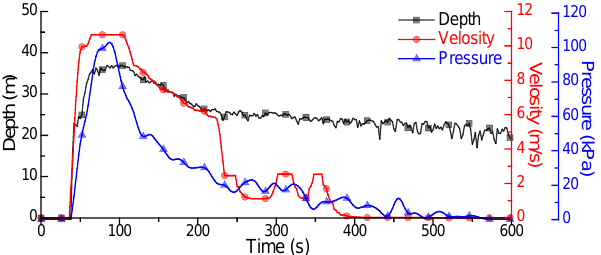
Figure 12. Numerical results of submerged depth, velocity and impact pressure at 0.5 km downstream of the dam toe.